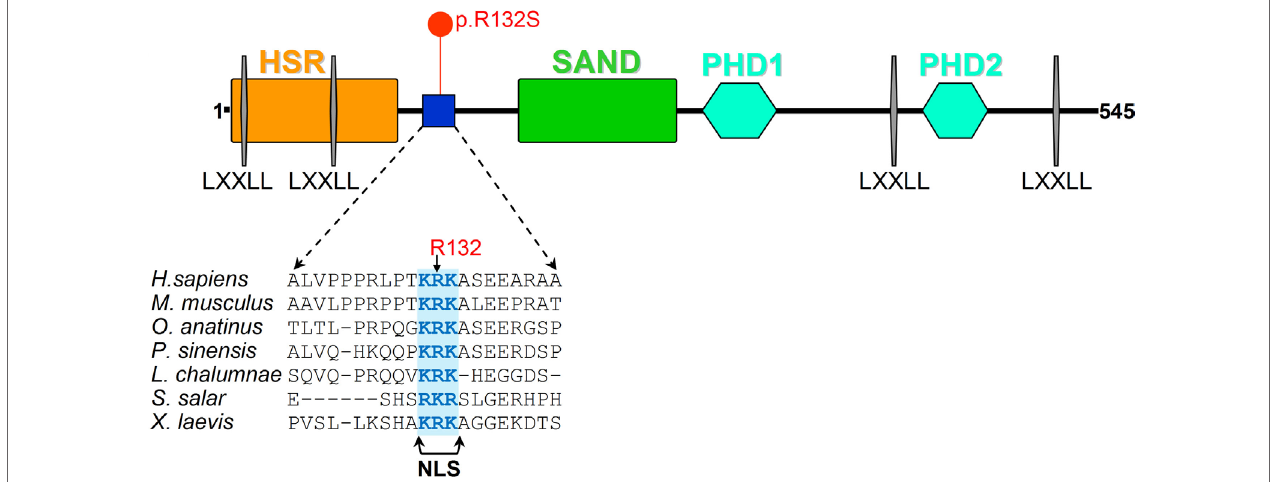
FIGURe 2 | Aire protein analysis representation. Schematic representation of Aire protein is shown along with the protein sequence alignment of the region surrounding the site of the p.R132S amino acid replacement among vertebrates. The functional nuclear localization signal (NLS) (6) is